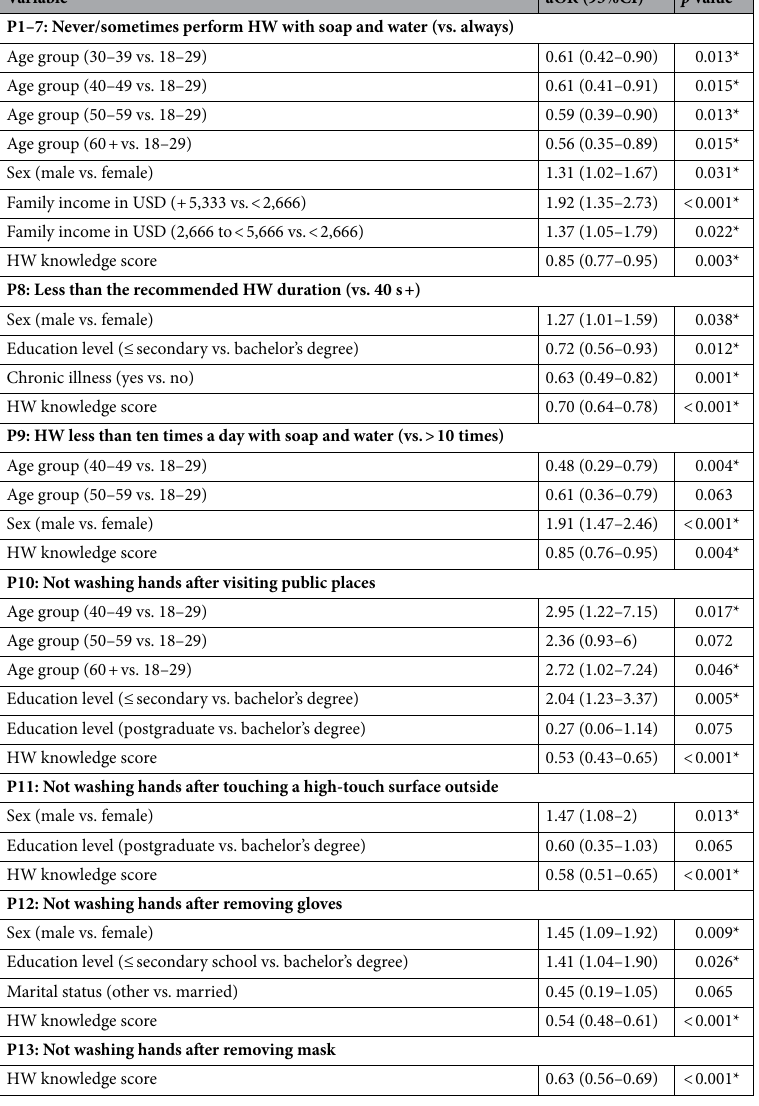
Table 7. Multiple logistic regression of factors associated with handwashing practice (technique, duration, frequency, and key time). Follow HW technique (never/sometimes vs. always); duration of HW (< 40 s